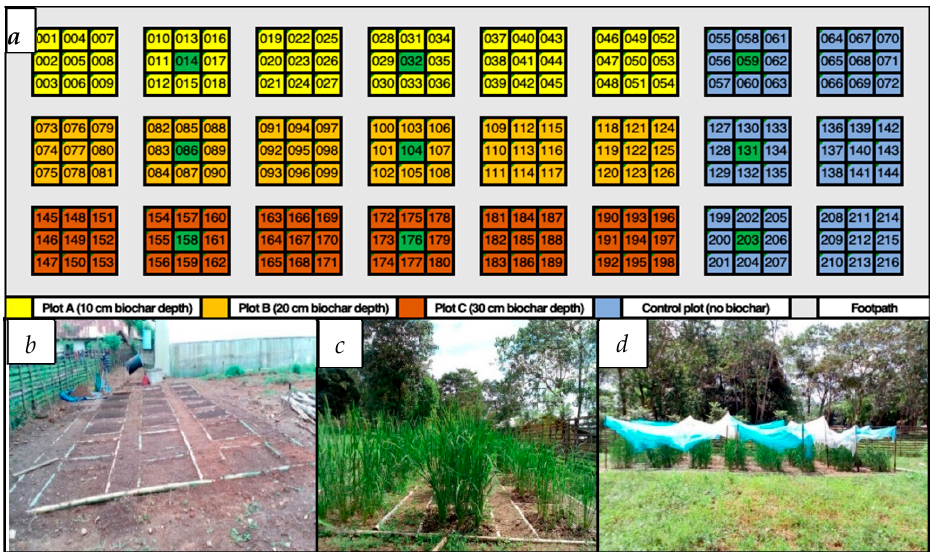
Figure 2. A sketch of the experimental field layout depicting the order of the rice plant hills in each plot (plate a ). Note that the big box is the plot and each of the small boxes with the numbers represent a rice hills in the plot. The di ff erent colors in (plate a ) indicate di ff erent biochar application depths and the green shades (plate a ) are the sampling points for soil moisture measurement. Plate ( b ) is on-the-ground picture of the sketch in plate ( a ). The next plates ( c ) and ( d ) show respectively the heading and milking growth stages of the NERICA-4 rice. Also note that the milking stage in plate ( d ) is covered with mosquito net to prevent bird